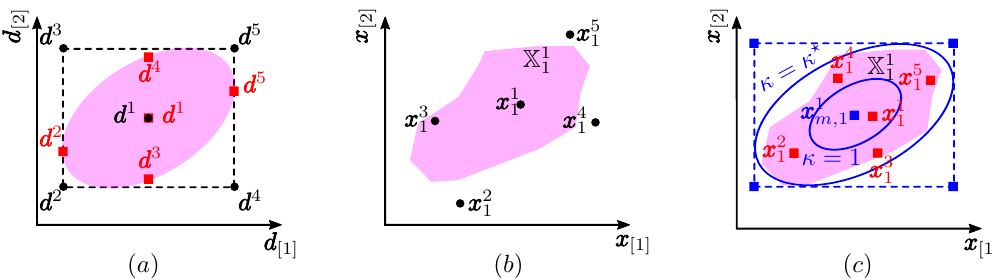
1 Figure 3. Comparison between multi-stage NMPC based on the vertex approximation and multi-stage NMPC based on the box over-approximation of the reachable states set. ( a ) Confidence region of the uncertain parameters ( b ) Predictions and the reachable set for MS-VA NMPC. ( c ) Predictions, reachable set and over-approximation of the reachable set for MS-SB